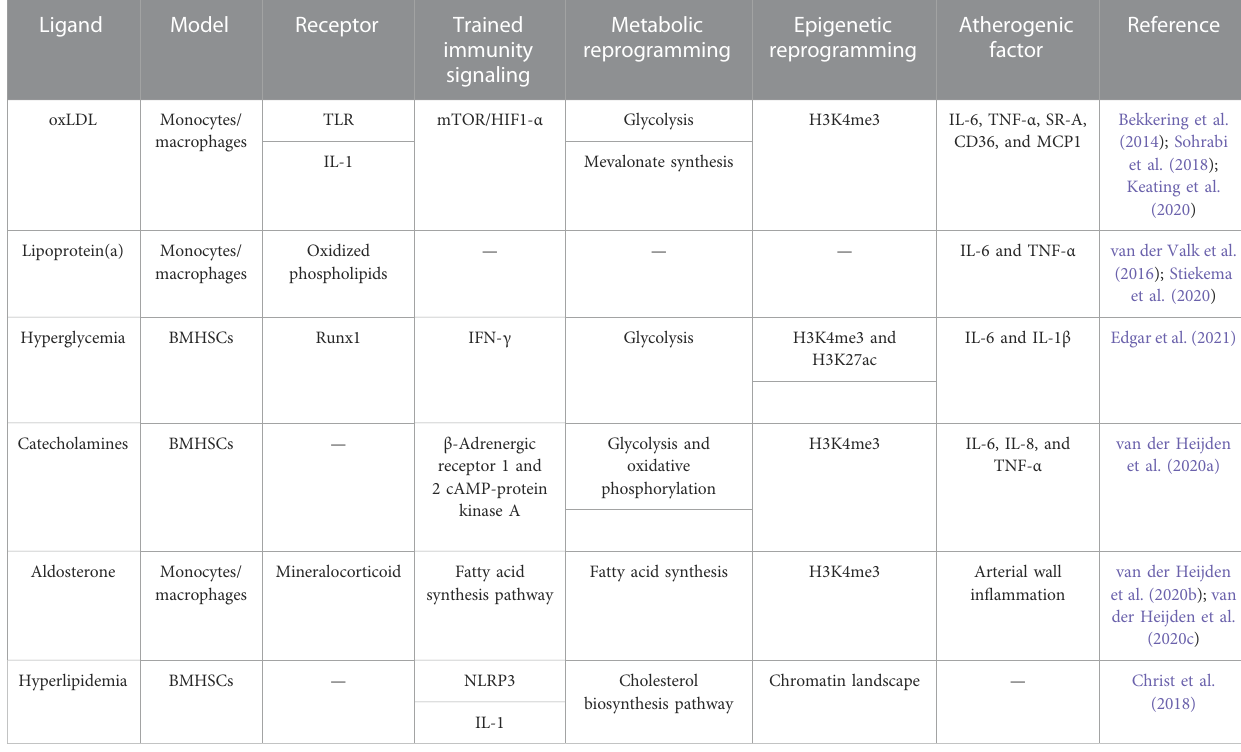
TABLE 1 Endogenous triggers of trained